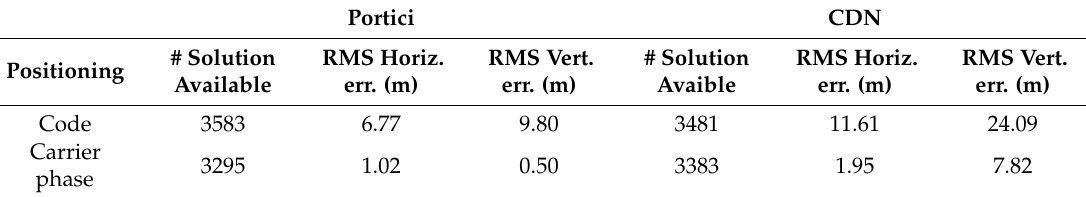
Table 1. Positioning performance for single-point positioning and carrier phase positioning for the Portici and CDN sites.